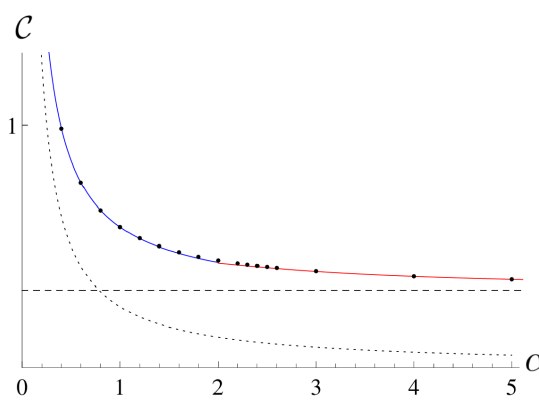
Figure 13: Geometric dimensionless capacitance (cid:67) of the paralell plate capacitor as a function of its dimensionless aspect ratio α . Results at infinite gap (dotted) and in the contact approx- imation (dotted) are actually rather crude compared to the more sophisticated approximate expressions from Eq. (61) for α < 2 and Eq. (66) for α > 2 (solid blue and red respectively), compared to numerical solution of Eqs. (57,58) (black